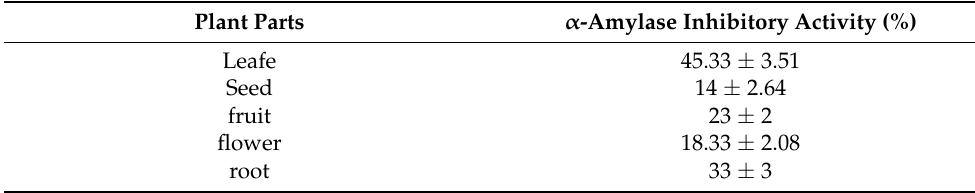
Table 1. Aqueous extract from different parts of the Moringa oleifera